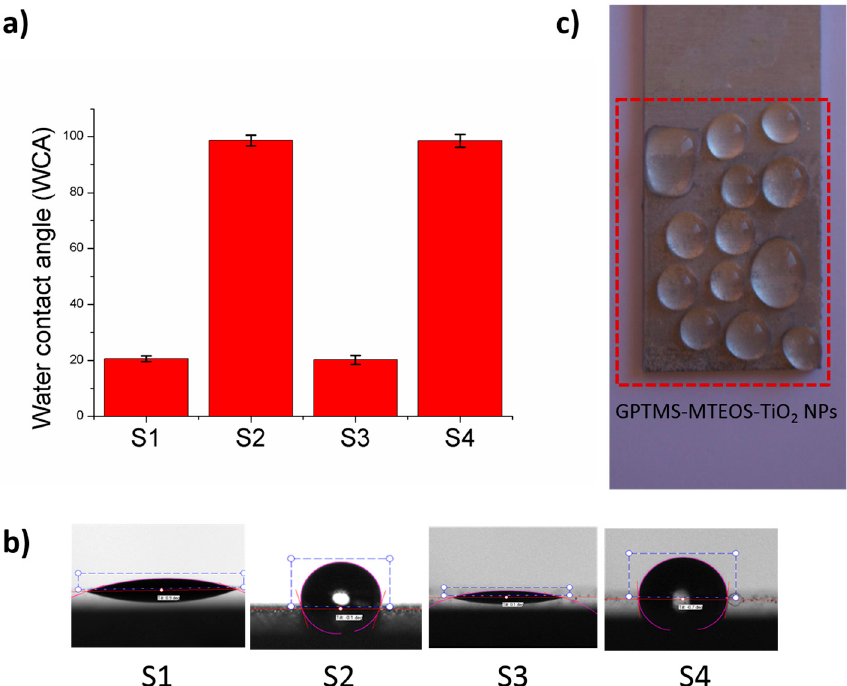
Figure 4. Variation of the water contact angle values ( a ) and aspect of the water droplets ( b ) for S1, S2, S3, and S4 samples. Water droplet images on hybrid sol-gel coating based on TiO 2 NPs ( c ).